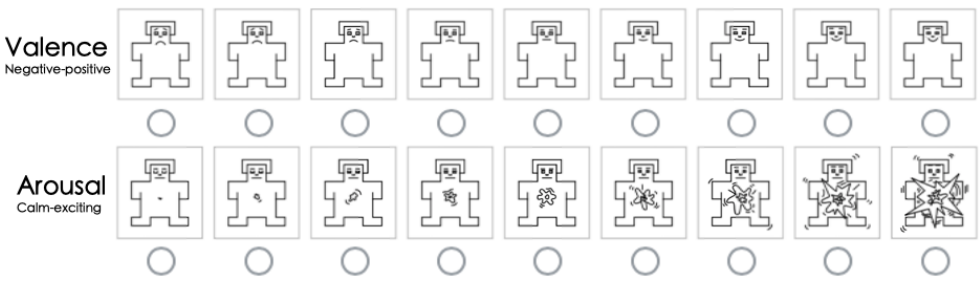
Figure 6. The manikins of the 9-point SAM scale used in our